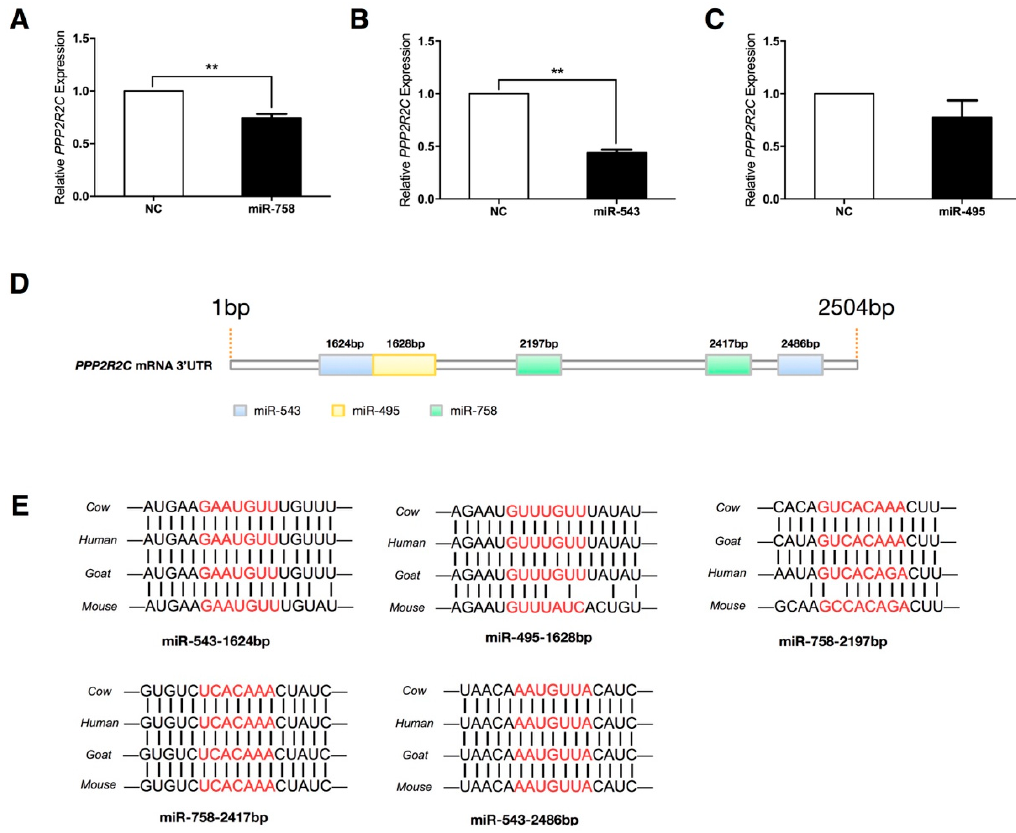
Figure 5. Protein phosphatase 2 regulatory subunit B, gamma ( PPP2R2C ) expression is inhibited by miR-758 and miR-543. ( A – C ) RT-PCR analysis of PPP2R2C in the presence of miR-758 mimics, miR-543 mimics, and miR-495 mimics in differentiated myocytes; ( D ) Diagrams of the potential miR-758, miR-543, and miR-495 binding sites in the 3 ′ untranslated region (3 ′ UTR) of PPP2R2C mRNA; ( E ) Sequence alignments of the five miRNA binding sites among mammals. Error bars represent SEM. “**” represents p < 0.01.